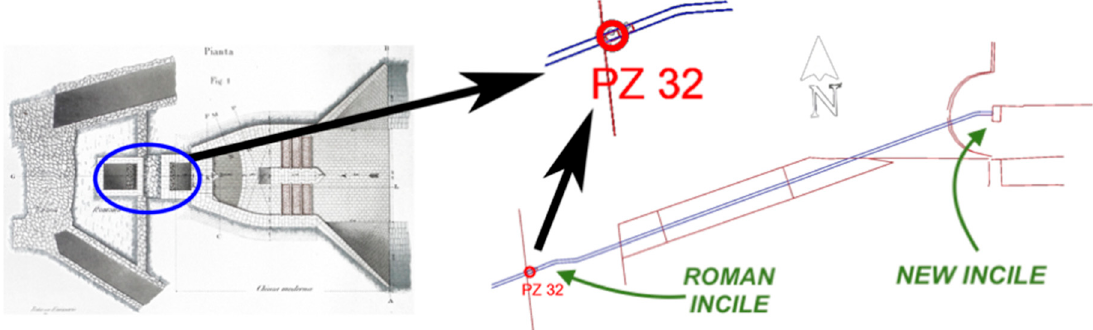
Figure 8. Analogies between Torlonia's modified incile and Torlonia’s emissary.